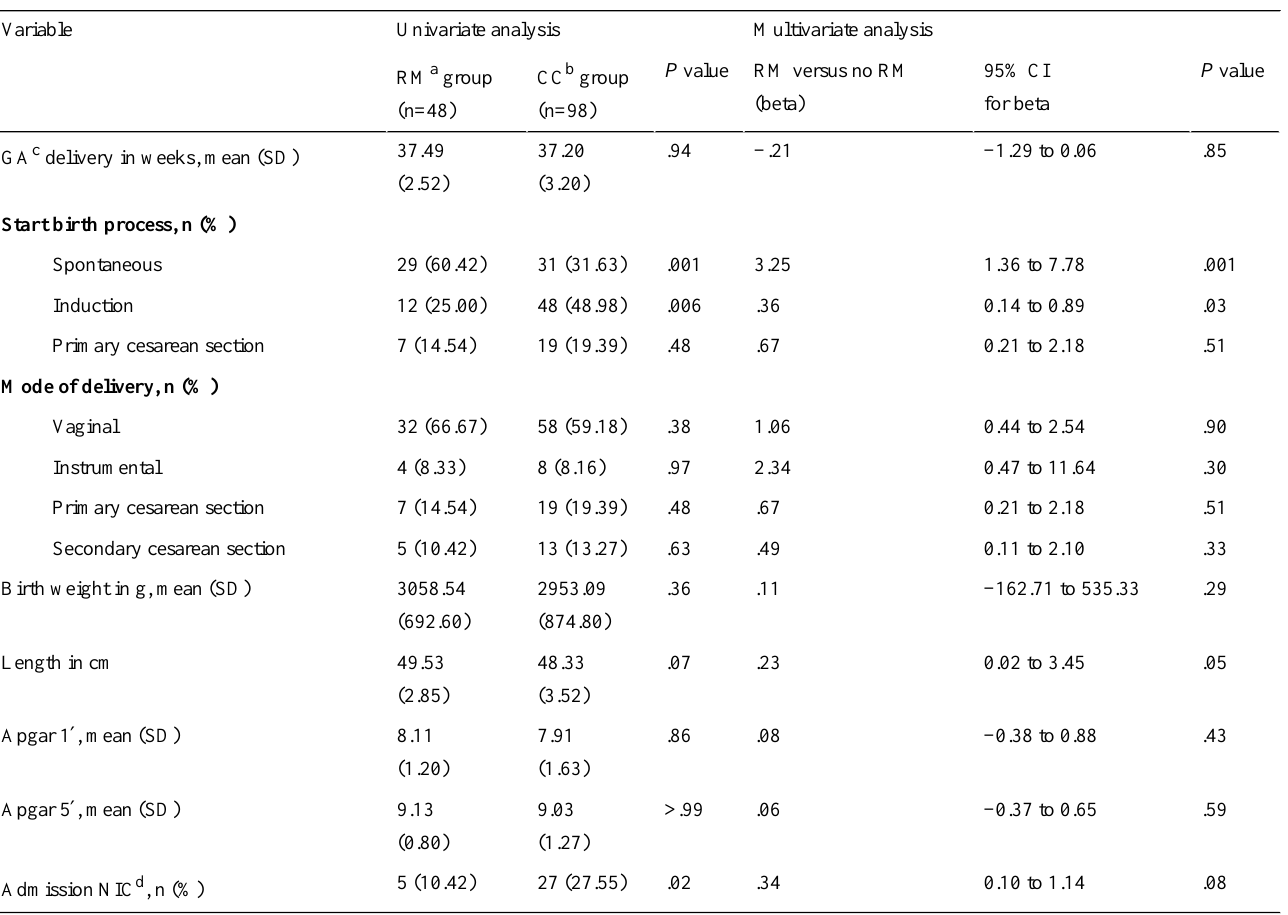
Table 3. Delivery outcomes.